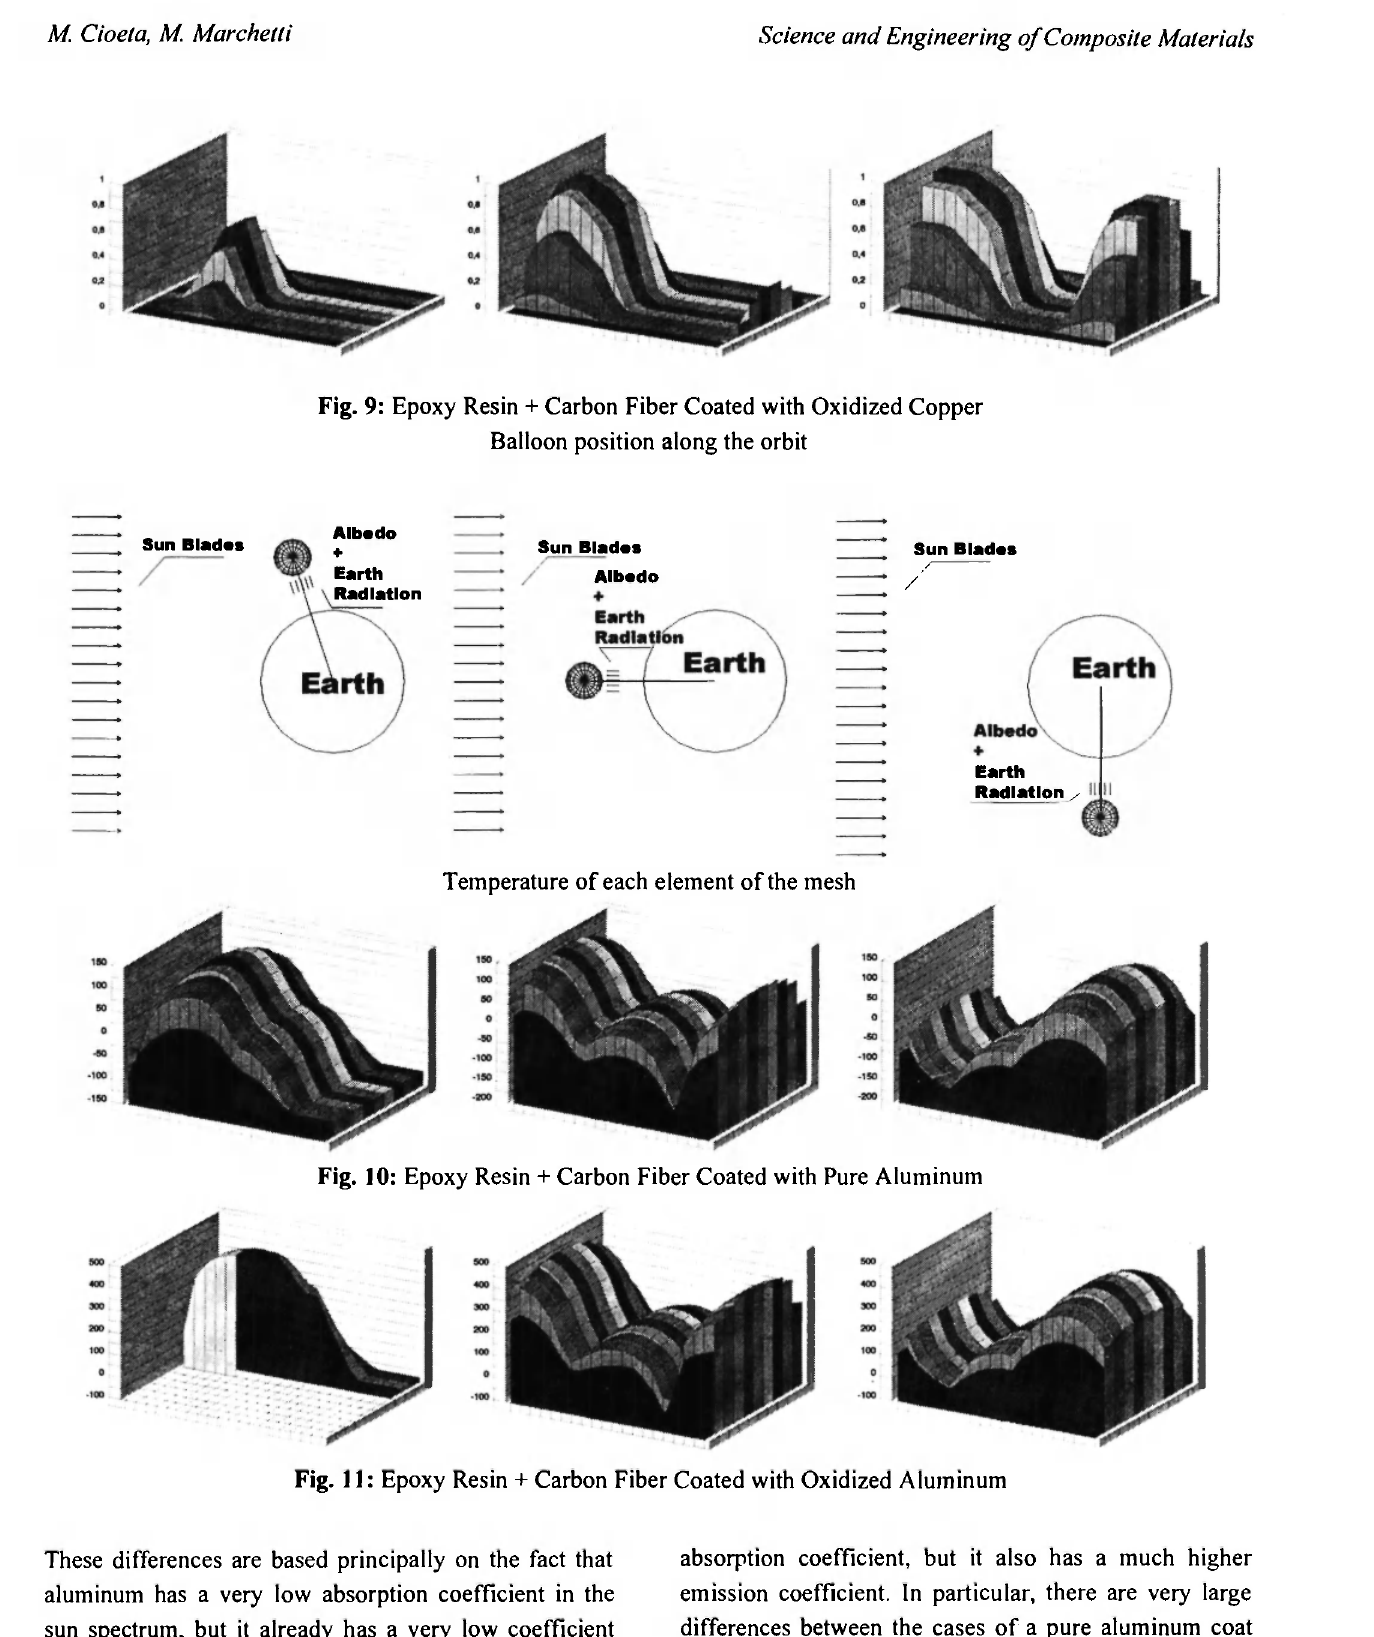
Fig. 9: Epoxy Resin + Carbon Fiber Coated with Oxidized Copper